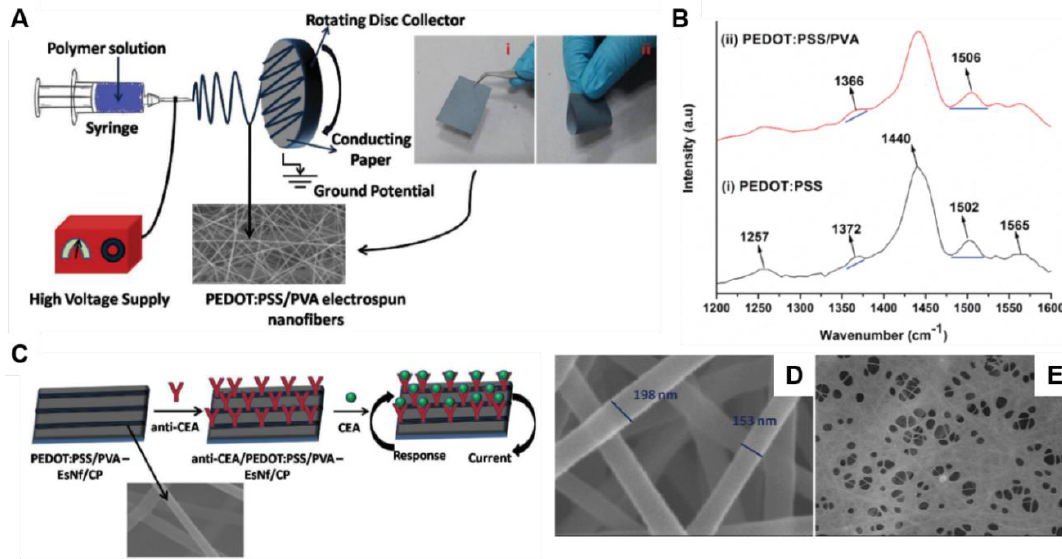
Figure 9. Scheme of the electrospinning setup for the obtention of PEDOT:PSS/PVA nanofibers ( A ). Raman spectra of PEDOT:PSS and PEDOT:PSS/PVA ( B ). Scheme for the biofunctionalization of the PEDOT:PSS/PVA nanofibers for carci- noembryonic antigen (CEA) detection ( C ). SEM images of PEDOT:PSS/PVA-EsNf/CP ( D ) and anti-CEA/P EDOT:PSS/PVA-EsNf/CP ( E ). Adapted with permission from reference [98]. Copyright 2016 John Wiley and Sons.